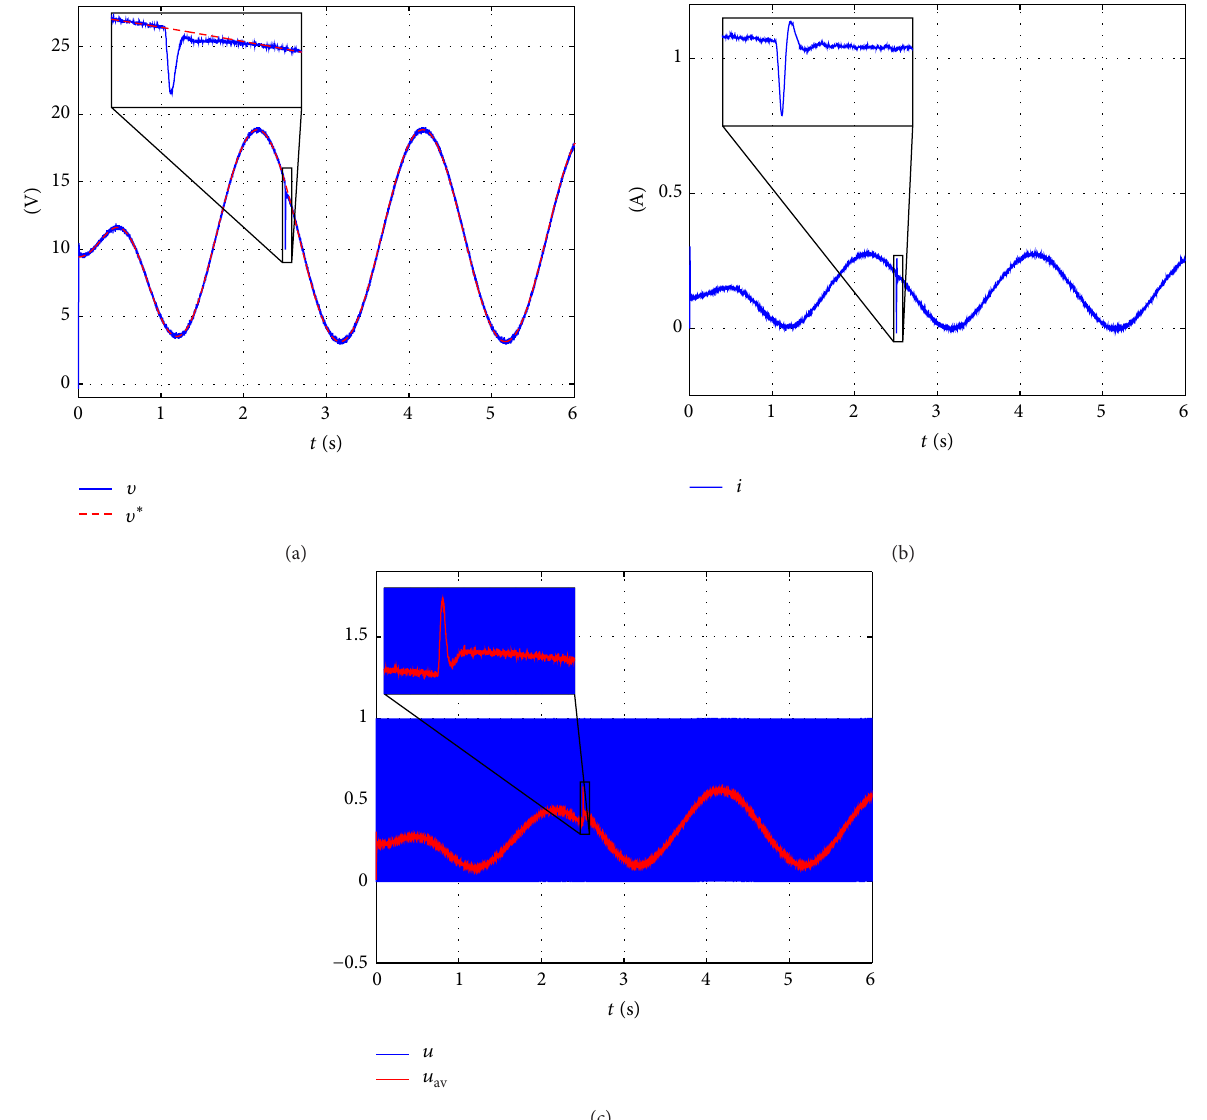
Figure 10: Case (iii) via Σ - Δ